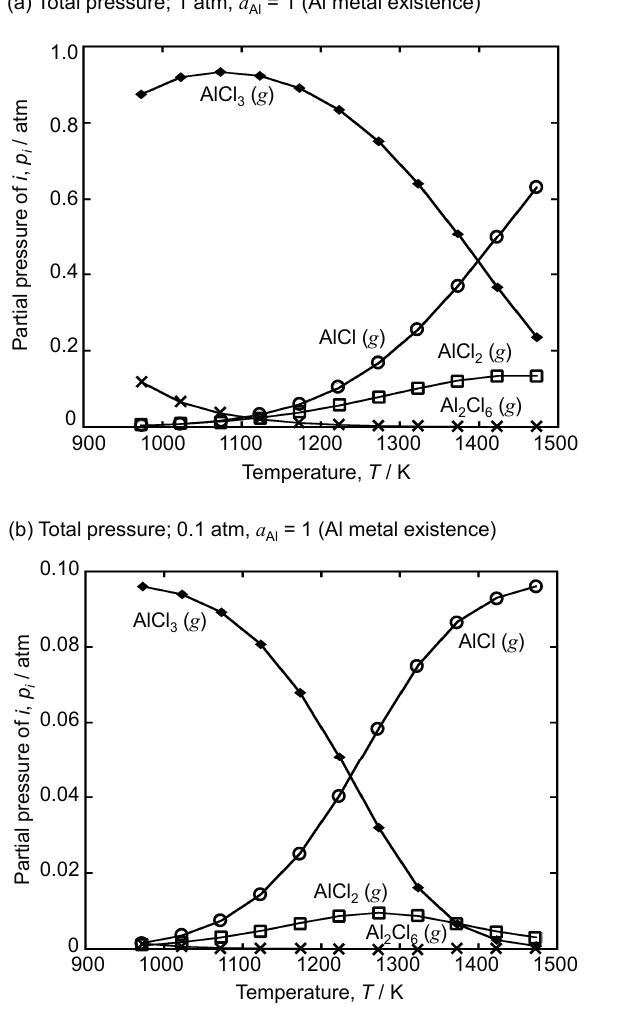
Figure 3. Equilibrium vapor pressure of aluminum chlo- rides [28] for total pressures of (a) 1 atm, and (b) 0.1 atm.